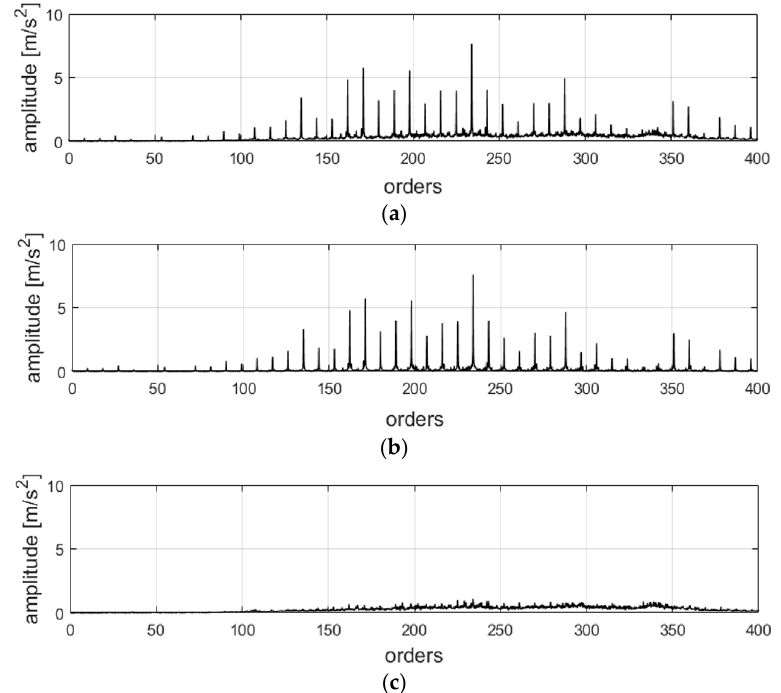
Figure 8. FFT of ( a ) acceleration signal, ( b ) synchronous average, and ( c ) residual signal for the signal acquired with sensor 1 in the case of the flawless pump (1500 r/min, 150 bar).